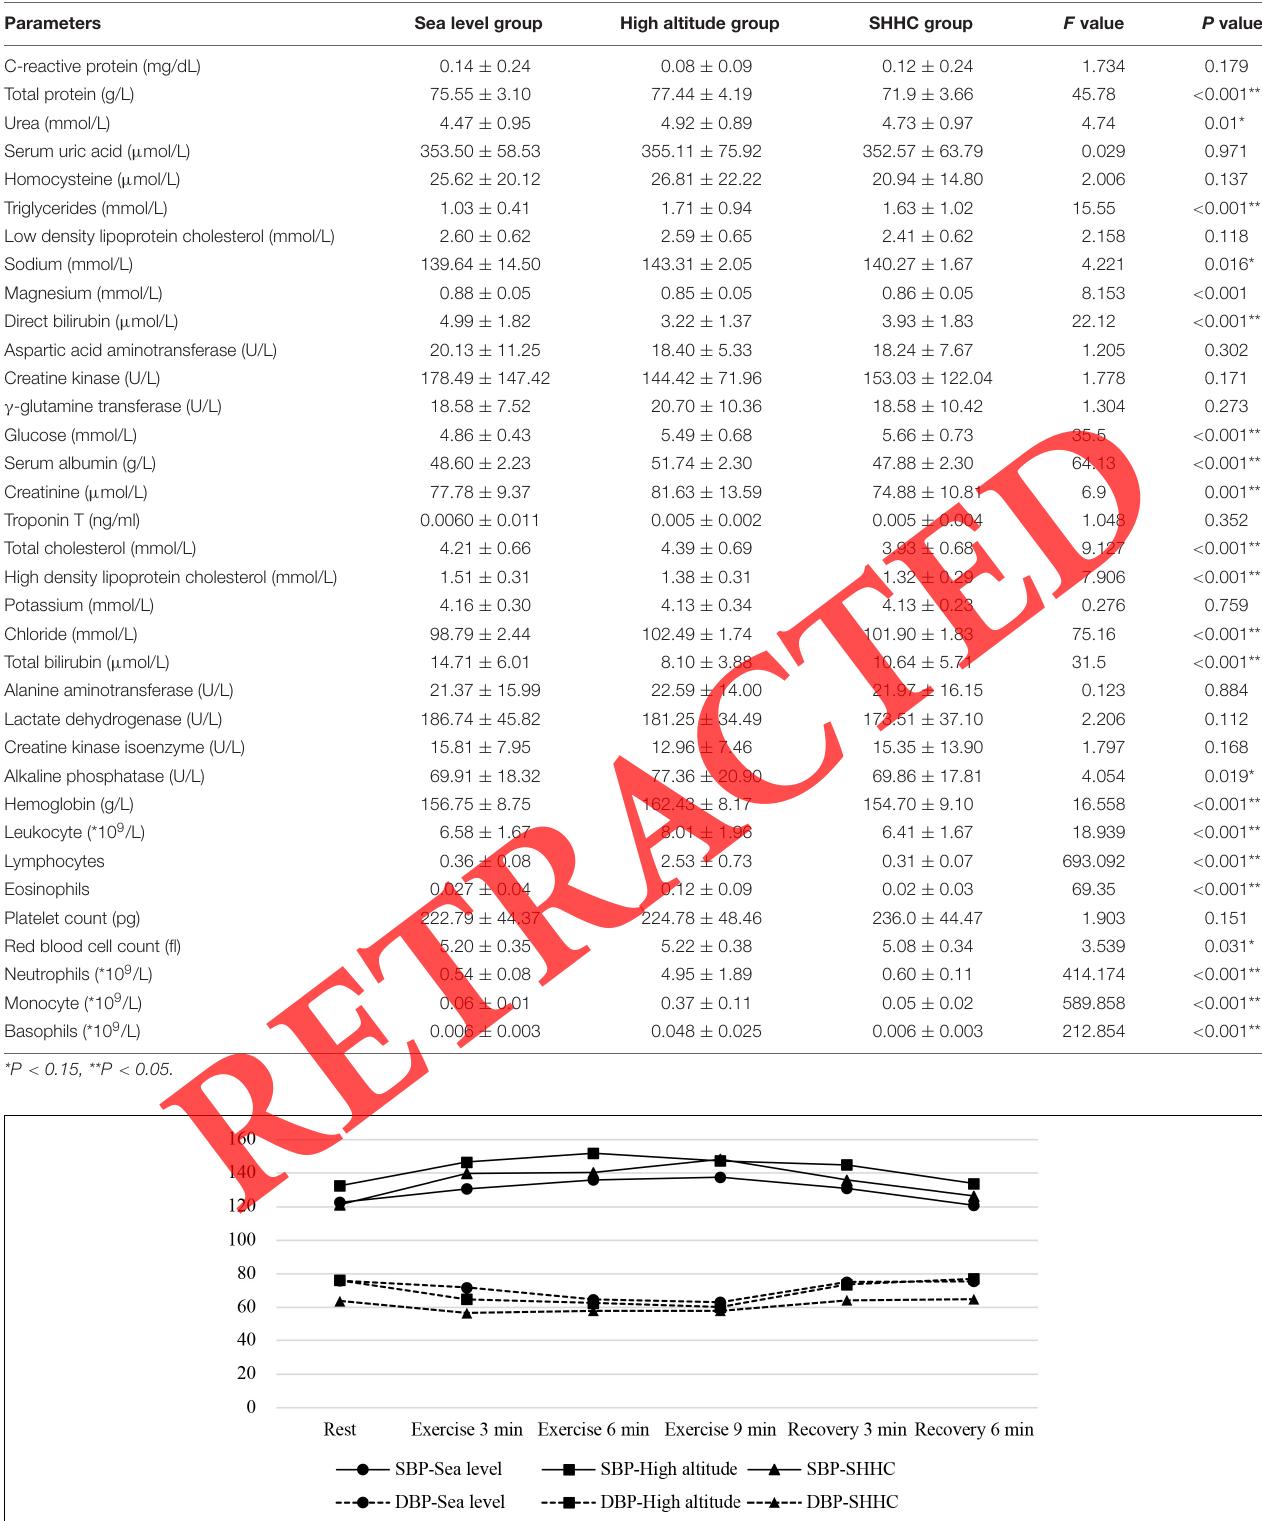
TABLE 1 | Comparison of circulating inflammation markers in three scenarios. Parameters